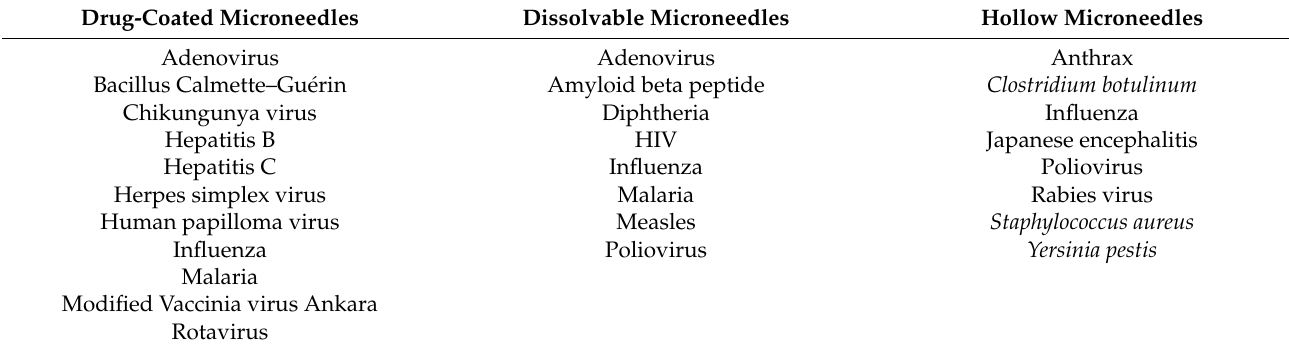
Table 1. Microneedles for commonly used vaccines